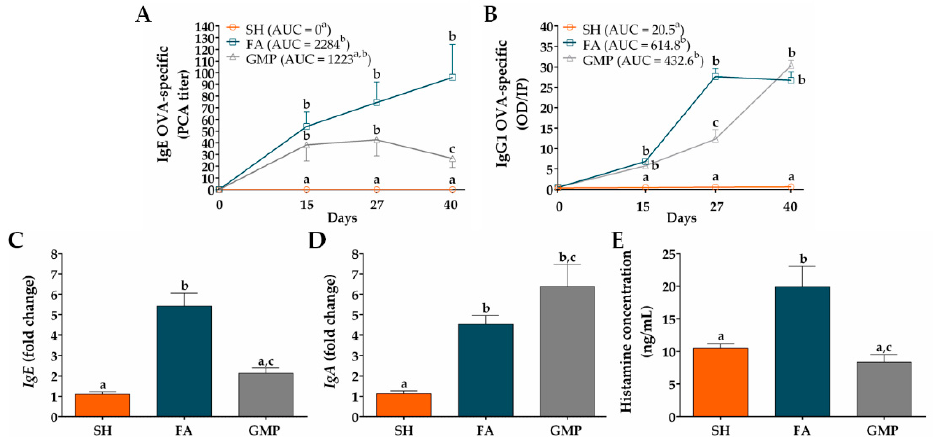
Figure 5. Effect of treatment with glycomacropeptide (GMP) on immunoglobulin and histamine levels in rats with food allergy (FA). ( A ) Ovalbumin (OVA)-specific IgE titers were measured in serum at different times by passive cutaneous anaphylaxis (PCA) reaction and represented as the inverse of the titer ( n = 9); the values of area under the curve (AUC) were evaluated. ( B ) OVA-specific IgG1 levels were measured in serum at different times by ELISA and represented as optical density (OD) of sample in relation to positive index (PI) ( n = 9); the values of AUC were evaluated. Intestinal expression level of total ( C ) IgE and ( D ) IgA relative to β -actin was analyzed by quantitative PCR and expressed as fold change ( n = 4). ( E ) Histamine concentration was measured by ELISA in serum samples obtained 30 min after allergen challenge at day 27 ( n = 9). SH, sham control; FA, FA-induced; GMP, FA-induced and GMP-treated animals. Different letters (a,b,c) indicate statistical difference.